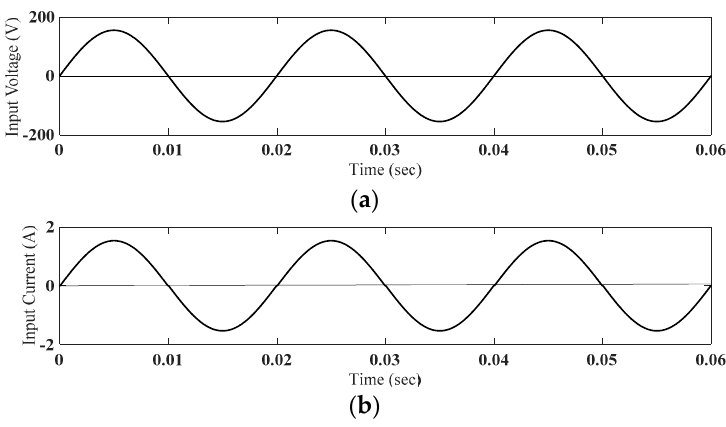
Figure 7. Simulation waveforms of ( a ) input voltage and ( b ) input current.